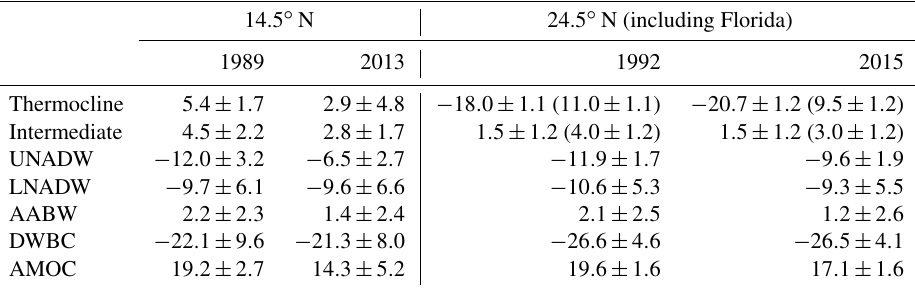
Table 3. The final adjusted transport (Sv) of water masses, DWBC, and AMOC intensity at the two sections in the respective years. Southward transport is marked with “–”. The values in the brackets at 24.5 ◦ N denote the transport results including the Florida Current transport in the corresponding water mass